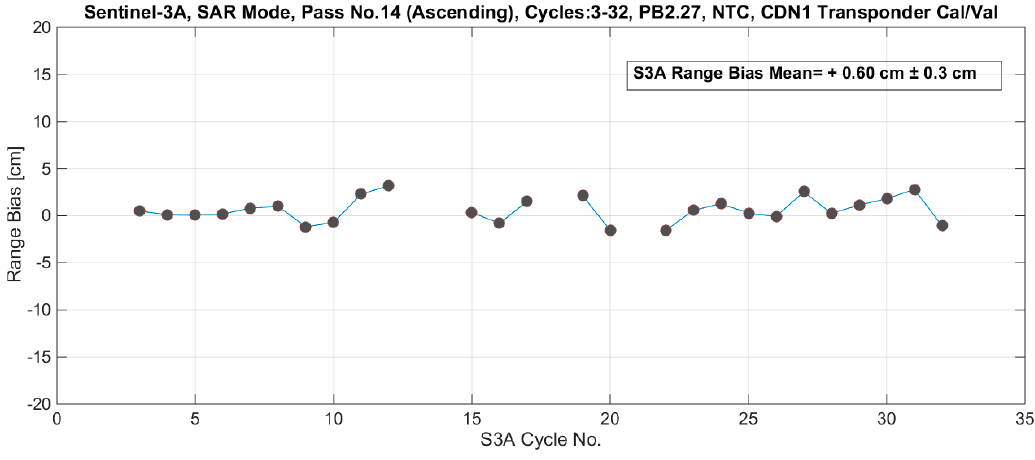
Figure 19. Absolute range bias results for the ascending Sentinel-3A Pass No.14, Cycles 3–32 at the CDN1 Cal/Val site.